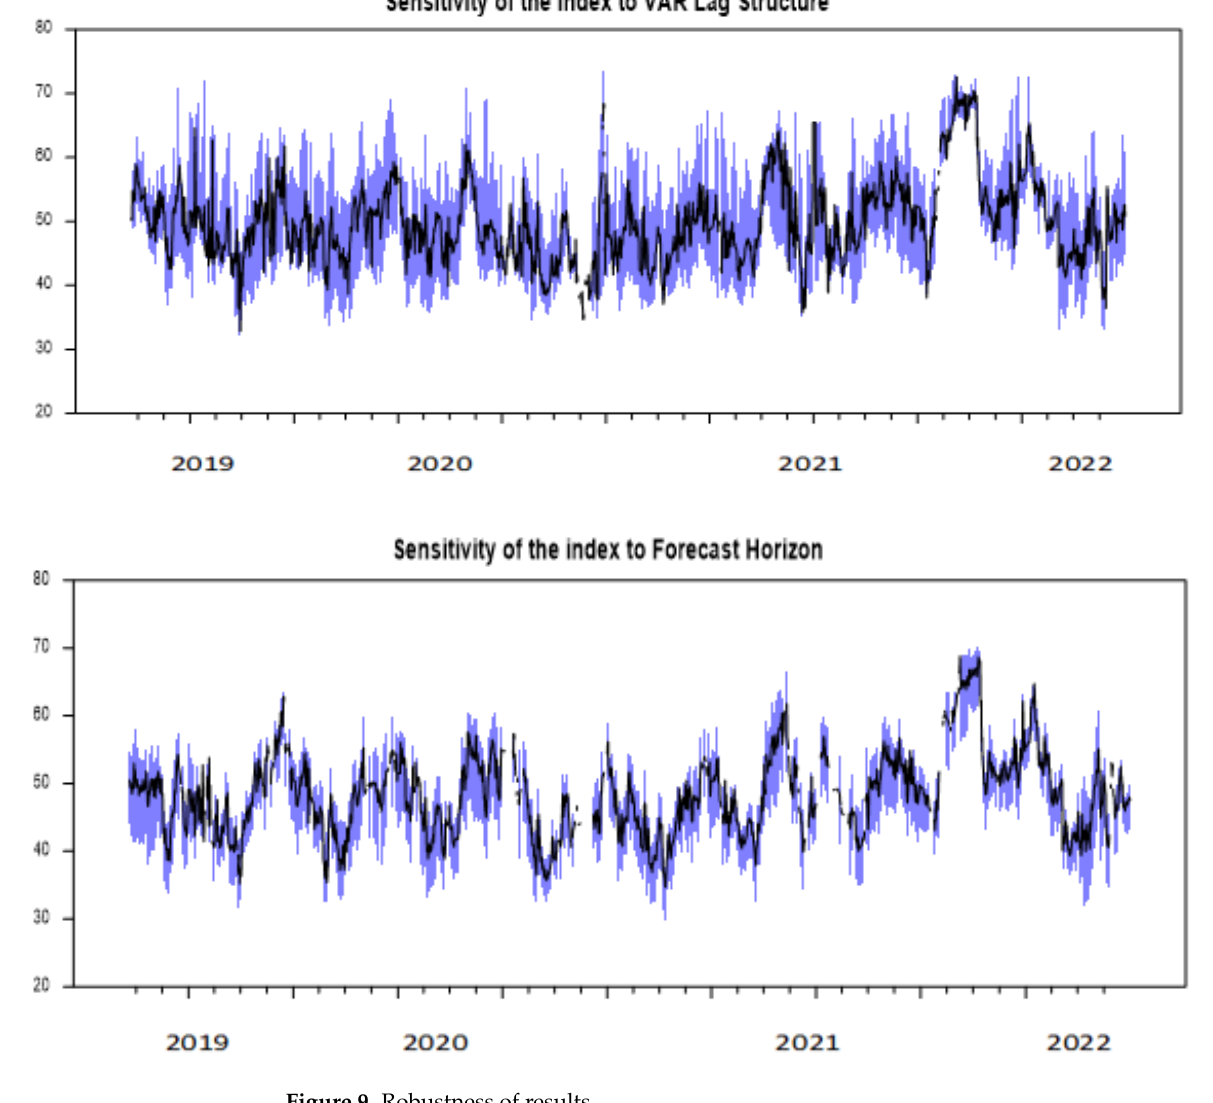
Figure 9. Robustness of results.